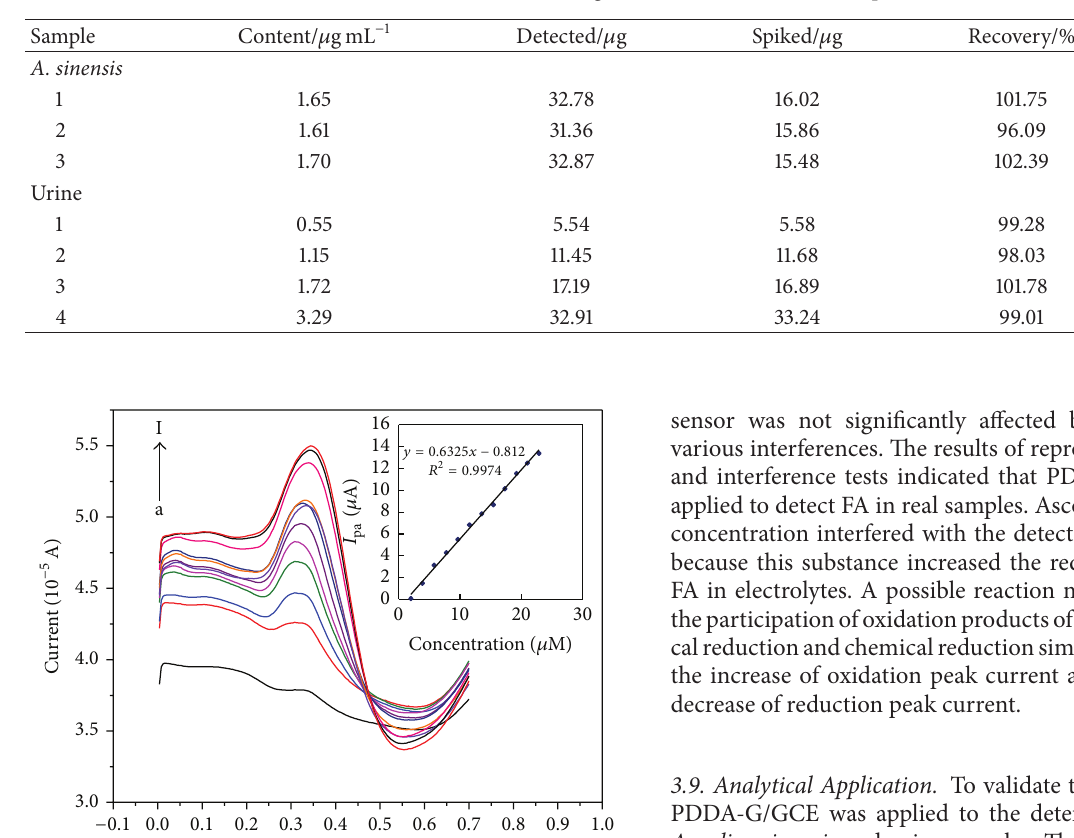
Table 2: Detection of FA in Angelica sinensis and in urine samples ( 𝑛 = 3 ).